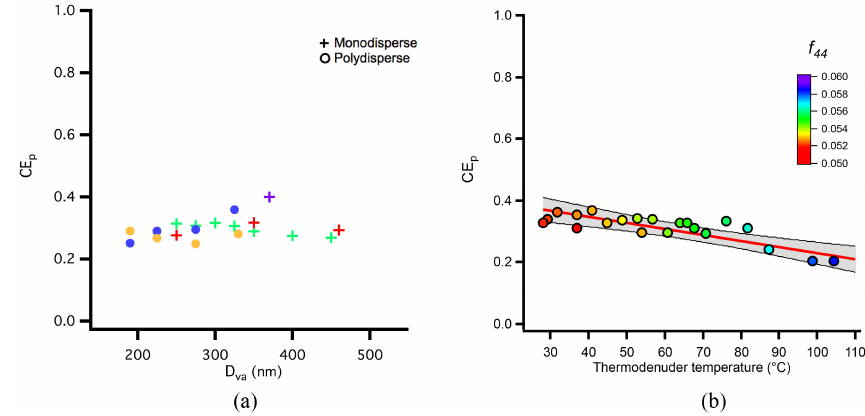
Figure 11. Collection efficiency of SOA as a function of D va and thermodenuder temperature. (a) Particle collection efficiency as a function of D va for all SOA experiments. Data are from both size-selected experiments (crosses) and polydisperse SOA from a smog chamber (circles), with each color representing a separate experiment. (b) Particle collection efficiency for 370nm size-selected particles (colored markers) as a function of thermodenuder temperature for an example SOA experiment, colored by the fraction of m/z 44 ( f 44 ) to the total organic mass measured in MS mode. Confidence intervals (95% CI) for a linear fit are shown (slope: − 0.0020 ◦ C − 1